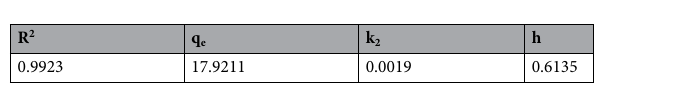
Table 2. Pseudo-second order model’s parameters for Eclipta alba powder.